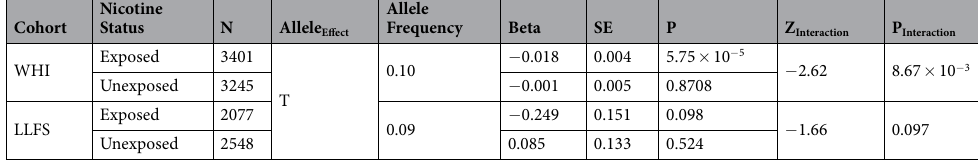
Table 1. Association between CYP2A6 rs113288603 and hearing loss symptoms in discovery and replication cohorts (WHI and LLFS, respectively).